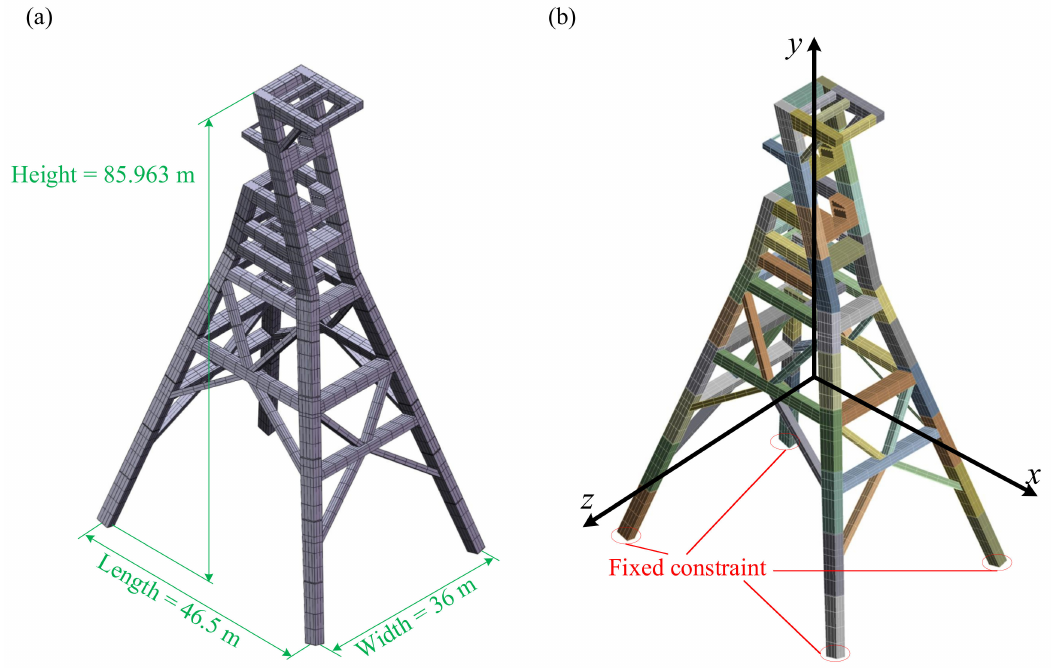
Figure 1. The models of the large headframe. ( a ) The 3D model. ( b ) The finite element model. (The origin of the coordinate is located at the mass center of the finite element